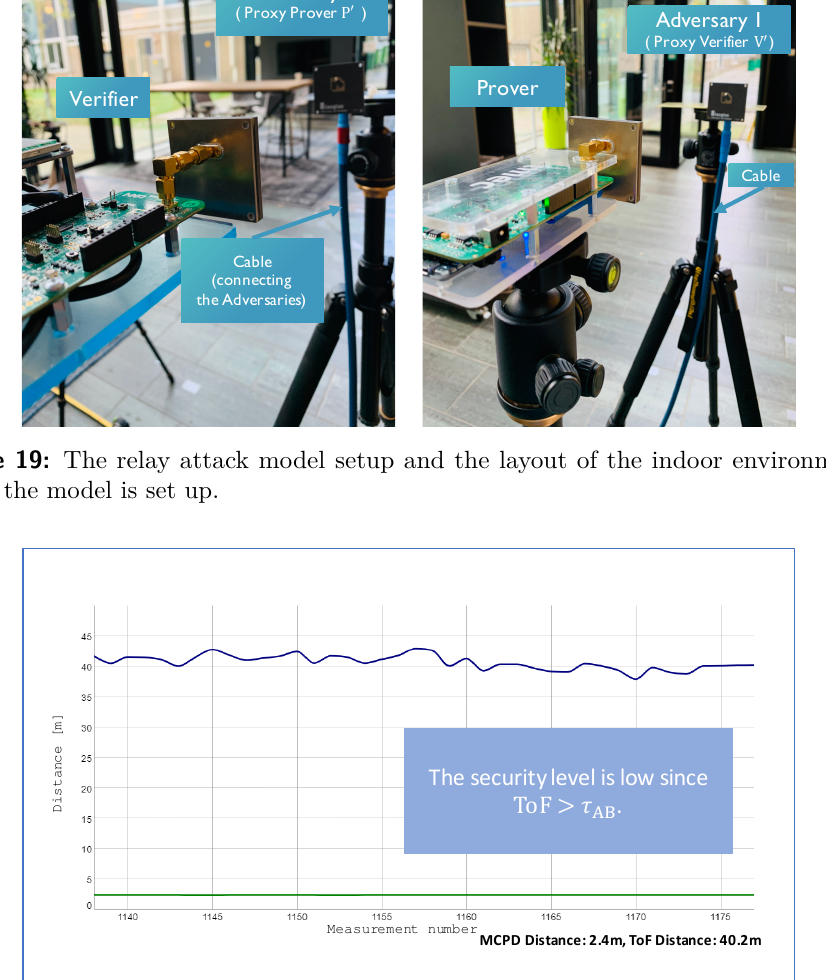
The security level is low since ToF > 𝜏 !" .